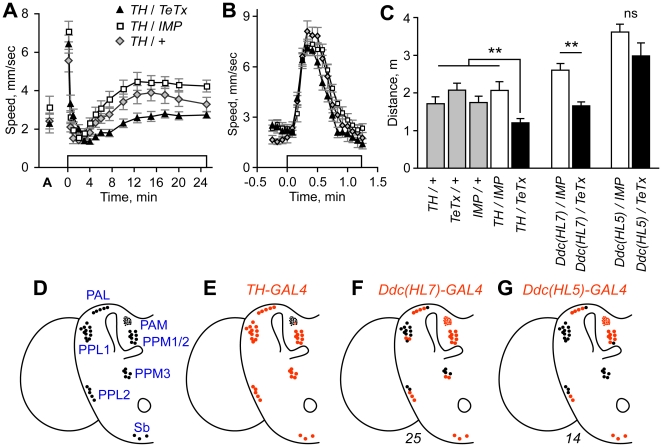
Blockade of evoked release from dopaminergic neurons reduced ethanol-induced hyperactivity.
A. Expression of active tetanus toxin (TeTx) or an inactive form (IMP) as a control in tyrosine hydroxylase (TH) neurons (full genotype: TH-GAL4/+;UAS-TeTx/+). Open box indicates time of ethanol vapor exposure (47% ethanol vapor concentration). ‘A’ indicates locomotor speed of acclimated flies in humidified air just prior to ethanol exposure. B. Higher resolution analysis of the olfactory startle response. Peak speed achieved between 0–1 min ethanol exposure did not differ between genotypes (P = 0.2722, 1 way ANOVA, n = 10). C. Distance traveled for hyperactivity onset. TH/TeTx was different from indicated control genotypes (**P<0.01, 1-way ANOVA, Dunnett's multiple comparison test, n = 10). Expression of TeTx with Ddc(HL7) but not Ddc(HL5) resulted in reduced ethanol-induced hyperactivity (Ddc(HL7): **P = 0.0006, Ddc(HL5): P = 0.139, 2 sample t-test, n = 9–10). All transgenes were heterozygous in animals tested for behavior. D. Dopaminergic neuron cell body positions in one hemisphere of the adult brain. Drawing was adapted from Friggi-Grelin et al. [20]. DA neuron nomenclature describes the location of the cell bodies in the adult brain (for example the PPM3s are one of three clusters of protocerebral posterior medial DA cells) [30]. E–G. The average number of TH-positive cells that expressed the indicated GAL4 transgenes (red). Only PAM cell number is underrepresented. Number of hemispheres counted is indicated below the diagrams. The TH-GAL4 expression pattern has been reported previously [20], [29].